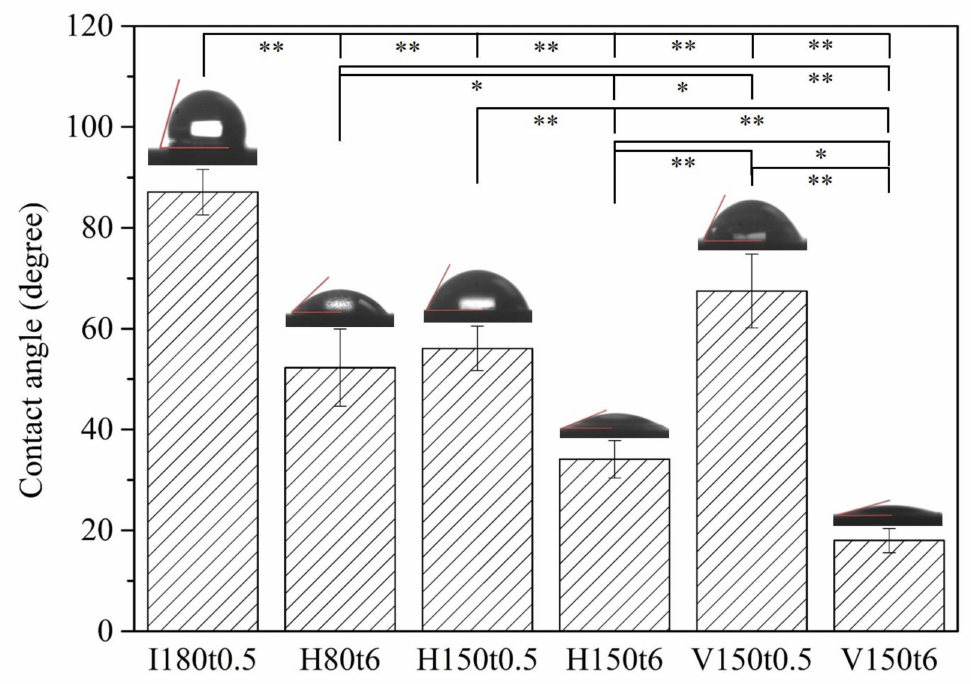
Figure 4. Water contact angles of anodized Ti–5Nb–5Mo under various hydrothermal or vapor thermal treatments. Statistical significance (*) was set at a p -value of < 0.05, and highly significant (**) as p <